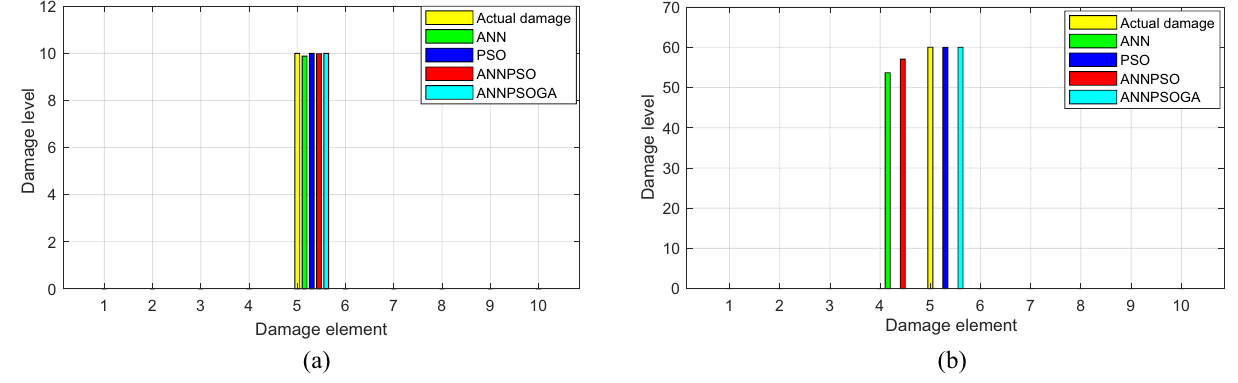
Figure 9. Damage identification of element 5 applying PSO, ANN, ANNPSO and ANNPSOGA: ( a ) 10% damage and ( b ) 60% damage.